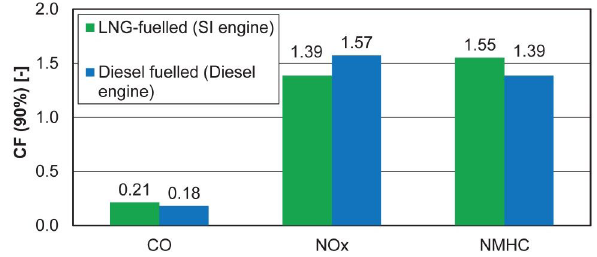
Figure 7: Measured conformity factor values for the specific emis- sion of carbon monoxide for the two tested buses.